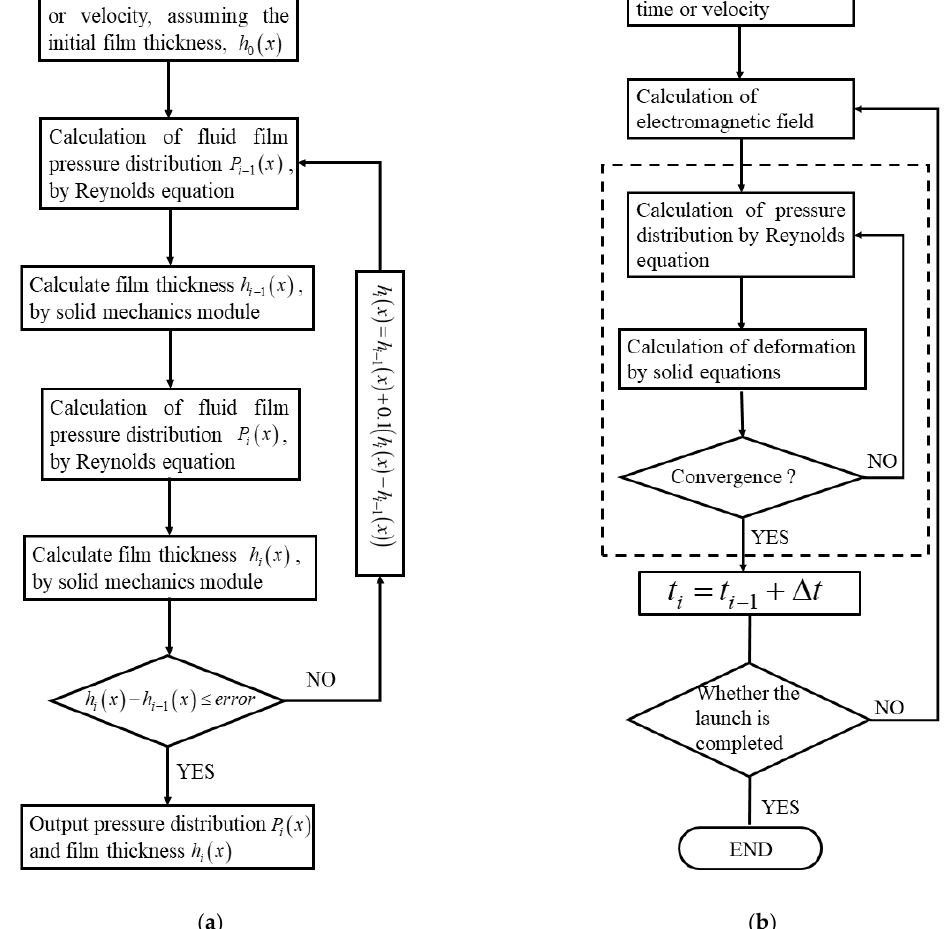
Figure 4. Calculation flow chart: ( a ) Iterative calculation flow chart, ( b ) Overall calculation flows chart.